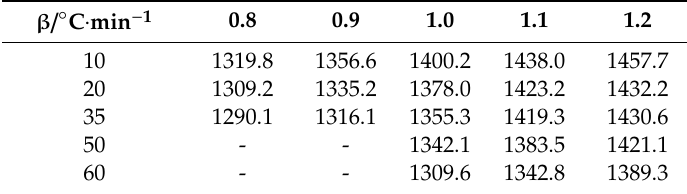
Table 4. Crystallization temperature of modified BFS / ◦